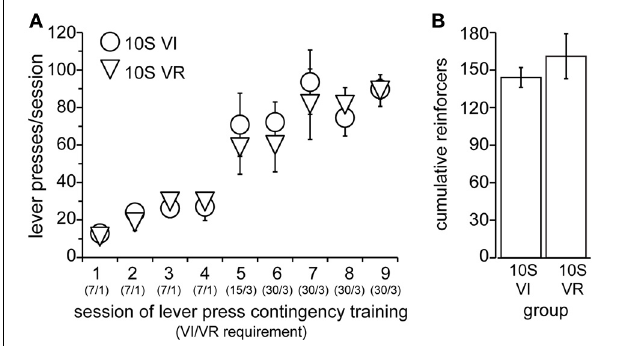
FIGURE 4 | Training of 10S groups. (A) Lever pressing by 10S VI (circles) and 10S VR (triangles) groups across training sessions. The numbers in parentheses beneath the session numbers on the x-axis indicate the programmed reinforcement criteria in effect for each group during that session (average time interval, in seconds, before a press yielded reinforcer delivery for the VI group/average number of lever presses required by VR group for reinforcer delivery). (B) The two groups did not differ in the cumulative number of reinforcers received across all training sessions.